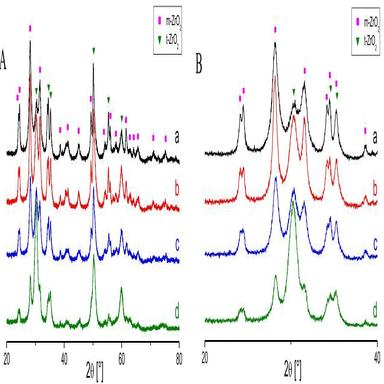
XRD patterns of pure ZrO2 (a, black) and CeO2-doped ZrO2 with increasing concentration of CeO2: 0.5%mol (b, red), 1%mol (c, blue) and 5%mol (d, green). Panel A is the full pattern, panel B shows a magnification in the range 20e40 of 2q. (For interpretation of the references to color in this figure legend, the reader is referred to the Web version of this article.)